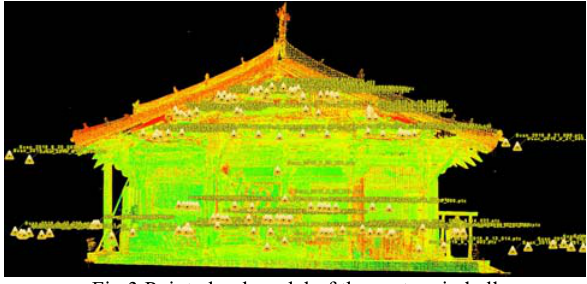
Fig.3 Point cloud model of the east main hall